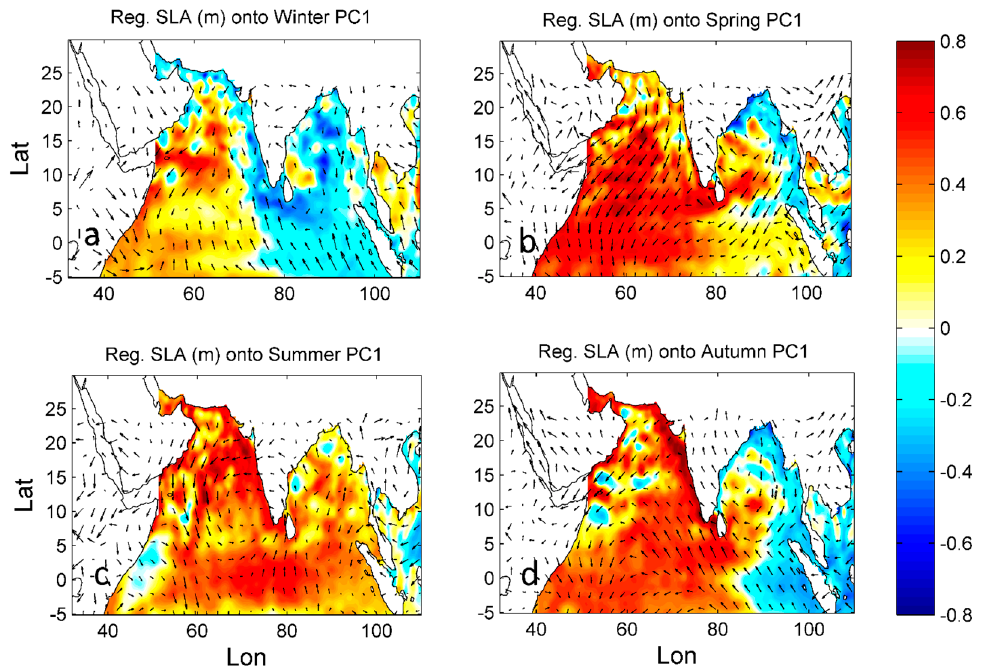
Figure 6. The spatial regression pattern of PC1 ( a – d ) onto surface wind and SLA (shaded) in the IO during winter, spring, summer, and autumn, respectively. Zero lines are omitted.